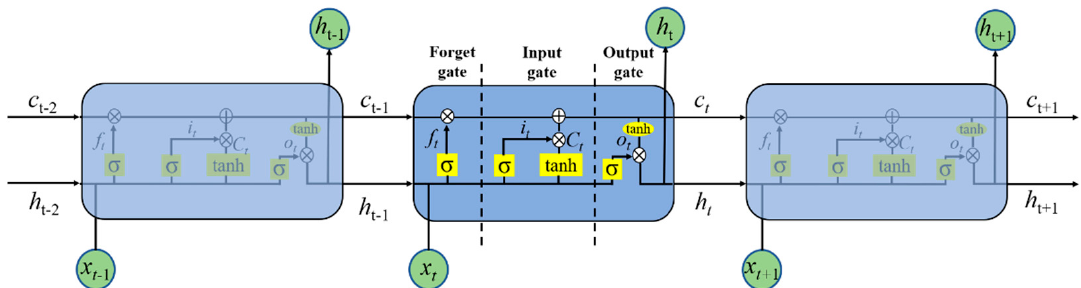
Figure 3. The LSTM architecture with f , i , o , which denote the three gates as the forget gate, input gate, and output gate, respectively. x , h , and c represent the input, output, and update state of each cell.